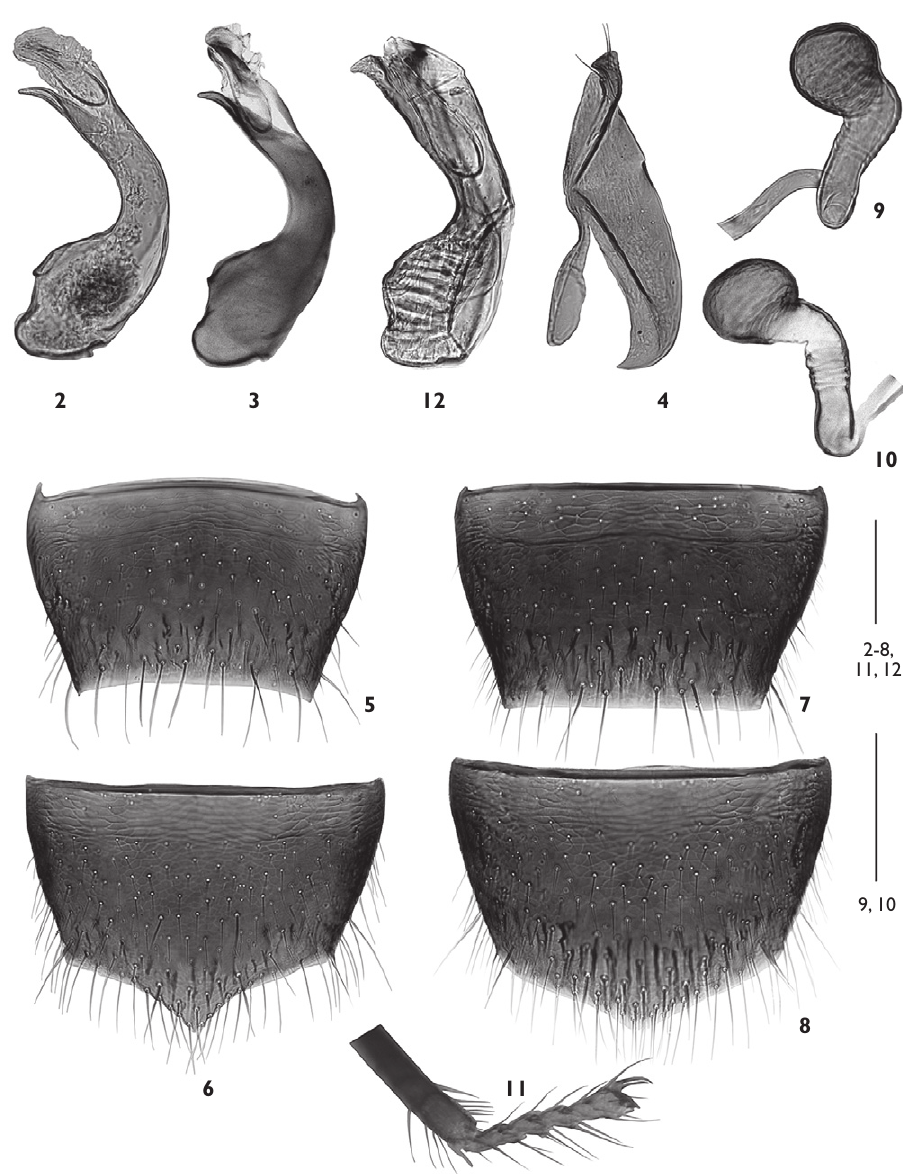
Figs. 2-12. Diglotta mersa (Haliday): 2, median lobe of aedeagus in lateral view (New Brunswick); 3, median lobe of aedeagus in lateral view (Europe); 4, paramere (New Brunswick); 5, male tergite 8 (New Brunswick); 6, male sternite 8 (New Brunswick); 7, female tergite 8 (New Brunswick); 8, female sternite 8 (New Brunswick); 9, spermatheca (New Brunswick); 10, spermatheca (Europe); 11, metatarsus with 4 articles (New Brunswick); 12, median lobe of the aedeagus of the holotype of D. littoralis in lateral view . Scale bars = 0.1